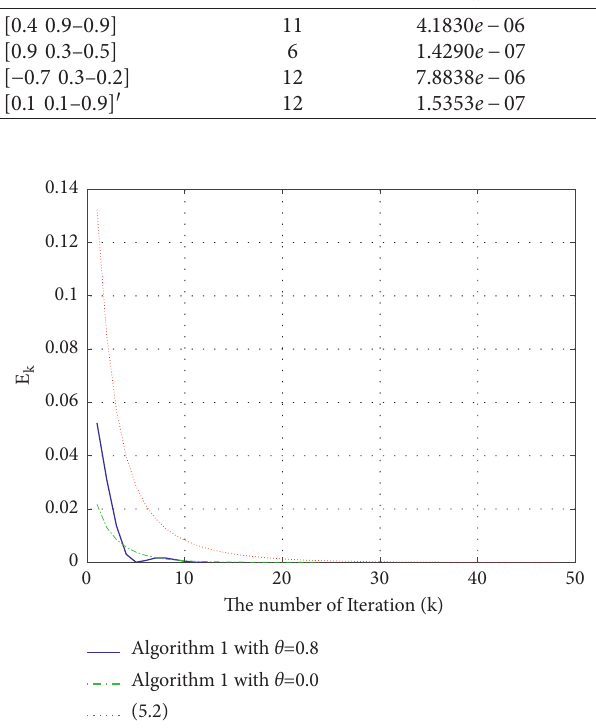
Figure 3: Error against of iterations for the comparision of Al- gorithm 1 and Scheme